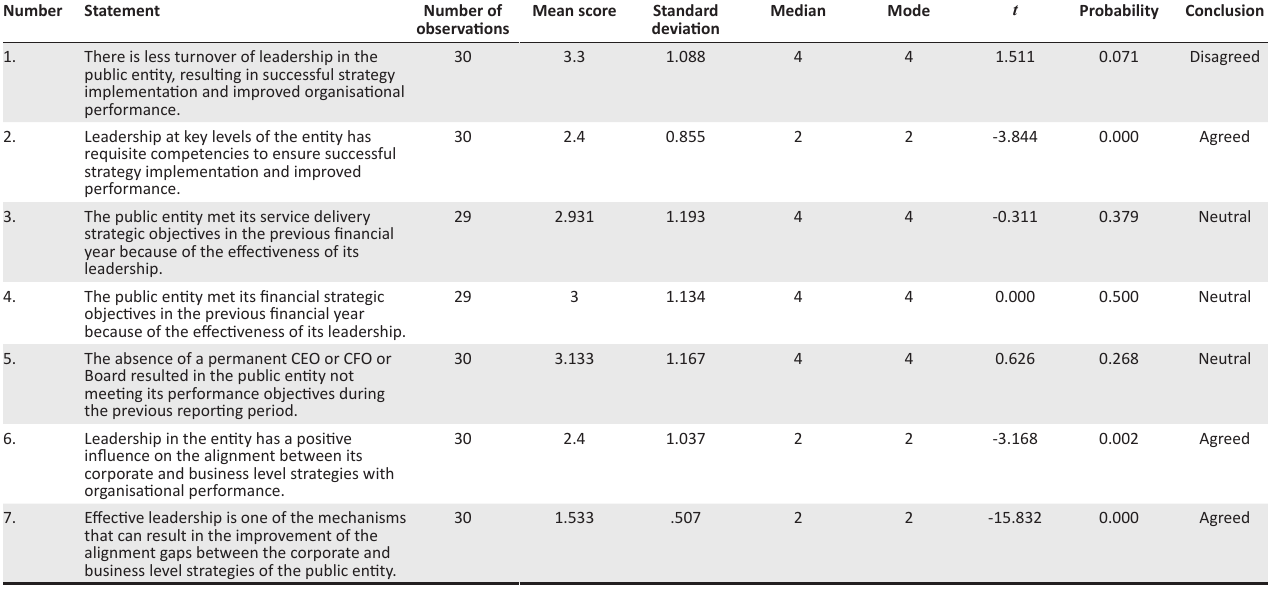
TABLE 1 : Role of leadership during strategy